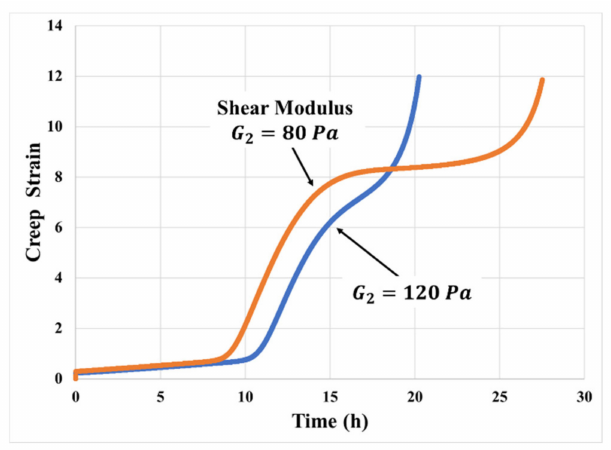
Figure 16. Effects of adhesive modulus on creep model prediction (50 kPa, 70 ◦